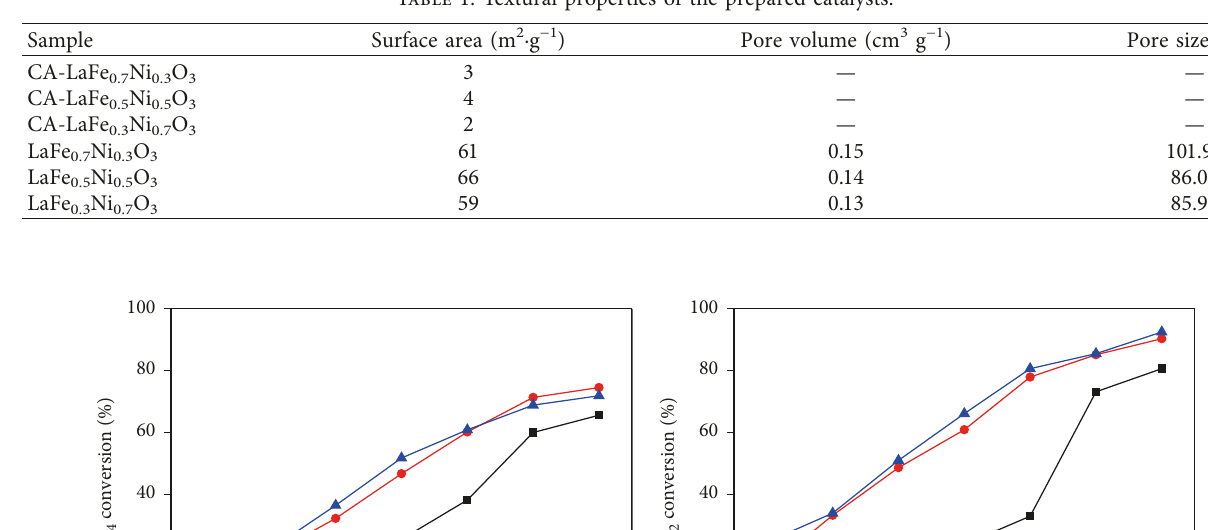
� 1.3:1.3:1, GHSV � 30,000mLh − 1 · gcat).